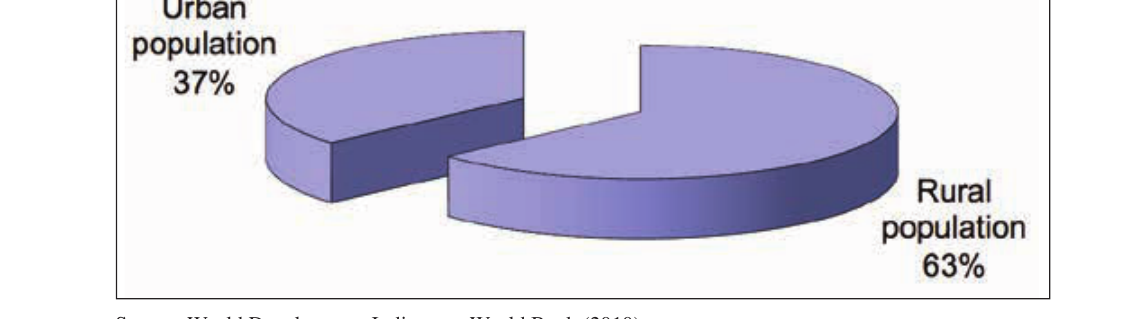
Rural-Urban Population of